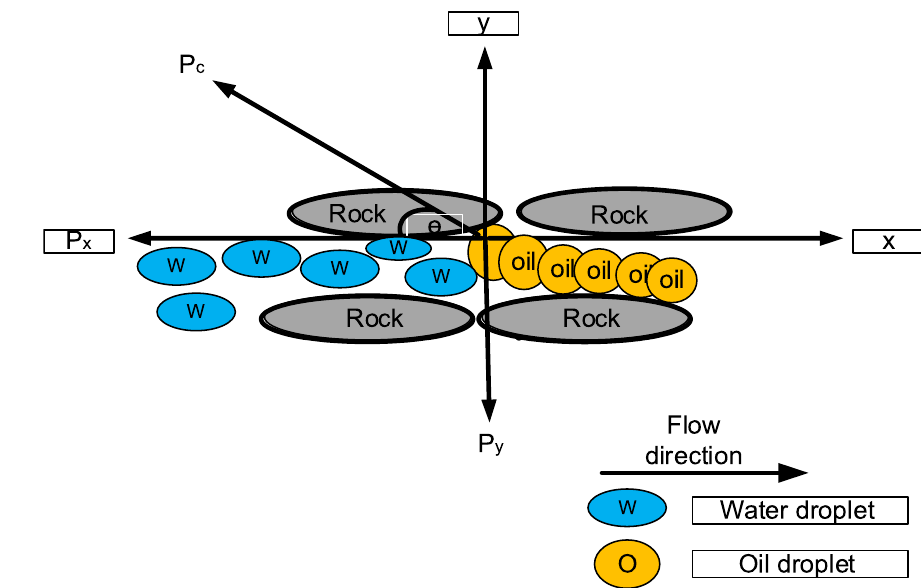
Fig.7 Forces acting on the oil droplet when it hangs from the bottom of the rock surface and its mass